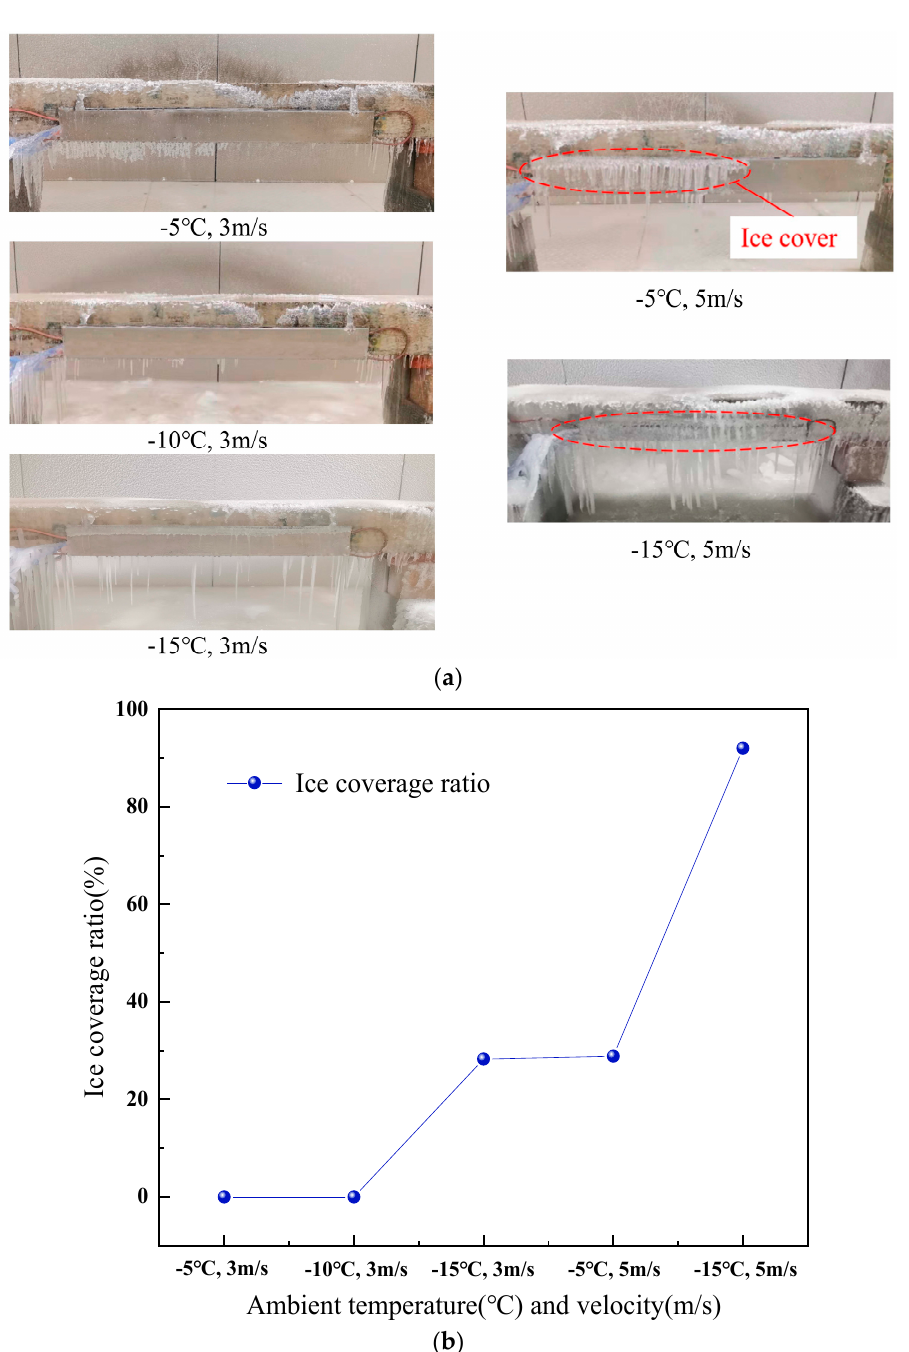
Figure 14. ( a ) Anti-icing effects under different environments; ( b ) variation of ice coverage ratio with ambient temperature and wind velocity.